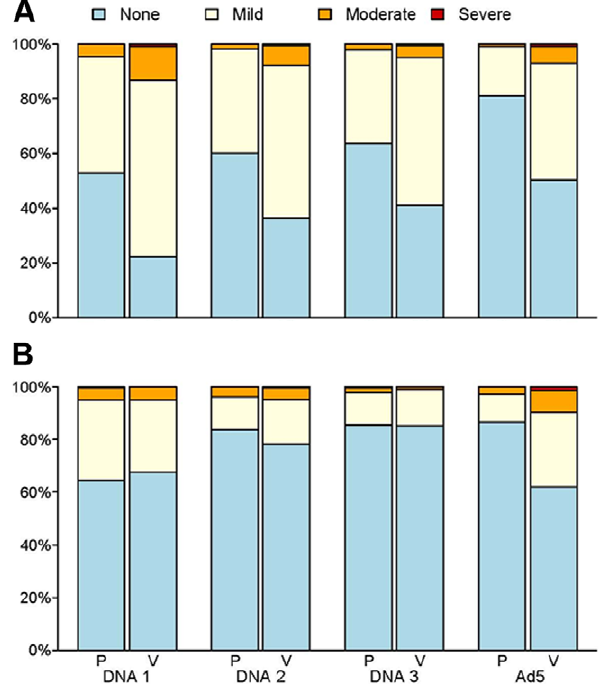
Figure 2. Maximal local and systemic reactogenicity after each vaccination. Frequency of local (A) and systemic (B) reactions occurring within three days following each DNA and rAd5 vaccination. Local injection site reactions included pain, tenderness, erythema and induration. Systemic reactions included malaise/fatigue, headache, chills, myalgia, arthralgia or increased body temperature. P=Placebo, V=Vaccine.